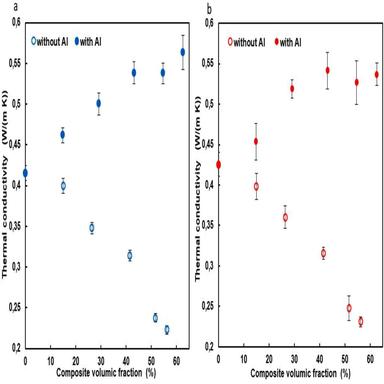
Thermal conductivity of the plaster panels containing PCM composite without and with aluminum at 285.15 K (a) and 313.15 K (b).